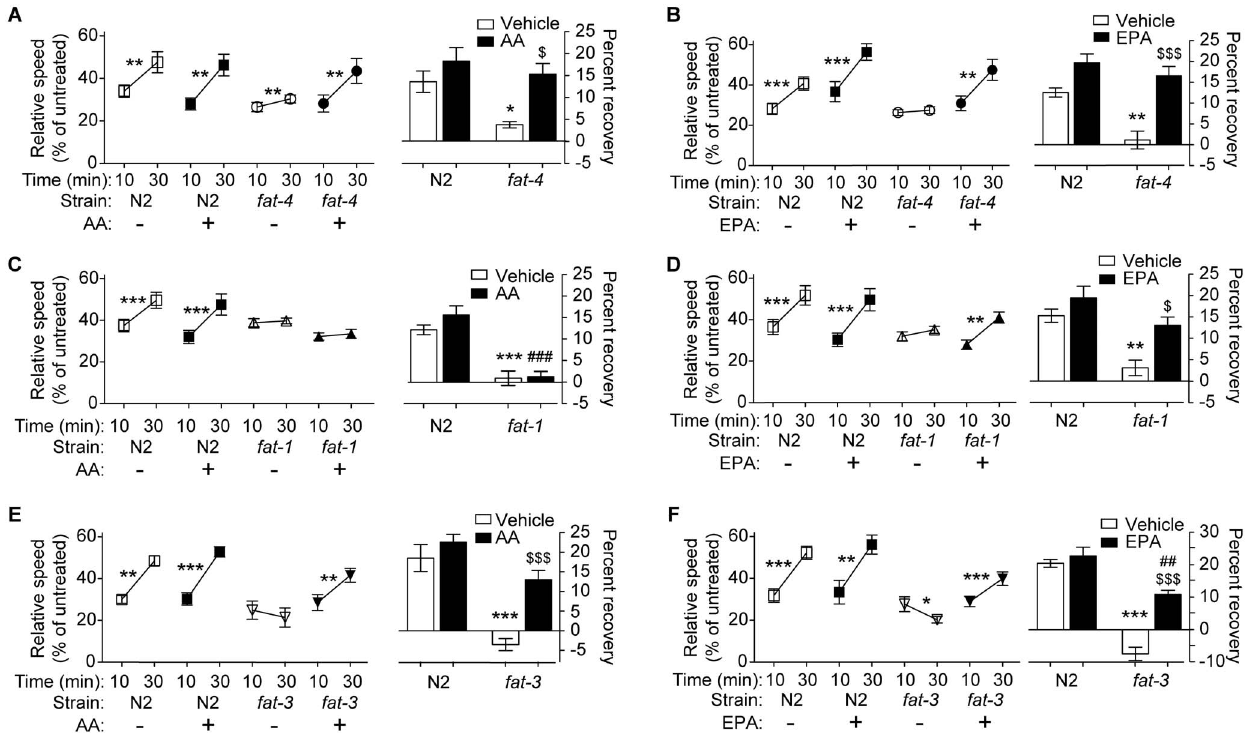
Figure 2. Dietary supplementation of EPA can rescue the AFT defect in mutants lacking LC-PUFAs. Animals were reared on NGM plates containing 0.1% NP - 40 and 0 or 160 m M AA (A, C, E) or 0 or 160 m M EPA (B, D, F). (A, C, E) Supplementation with AA is able to rescue the AFT defect of fat-4(wa14) (A) and fat-3(wa22) (E), but not fat-1(wa9) (C) mutants, suggesting that the conversion of AA to EPA by FAT - 1 is required for AFT. (B, D, F) Supplementation with EPA is able to rescue AFT in fat-4(wa14) (B), fat-1(wa9) (D) and fat-3(wa22) (F), indicating that EPA is sufficient to provide all LC- PUFA function that is required for AFT. Error bars represent SEM. * p , 0.05; ** p , 0.01; *** p , 0.001. n =6 for AA supplementation and n =5 for EPA supplementation.